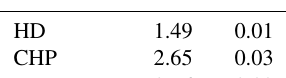
Table B1. Fixed-effect coefficients from the linear mixed models fitting reference sap flow density as a function of measured sap flow density using the data from the global sap flow calibration meta- analysis by Flo et al. (2019). Models for each method included the individual calibration as a random intercept. Sap flow methods are ranked according to their presence in the SAPFLUXNET database, from most to least present: HD (heat dissipation), CHP (compensa- tion heat pulse), HR (heat ratio), HPTM (heat pulse T-max), CHD (cyclic heat dissipation), and HFD (heat field deformation). Method